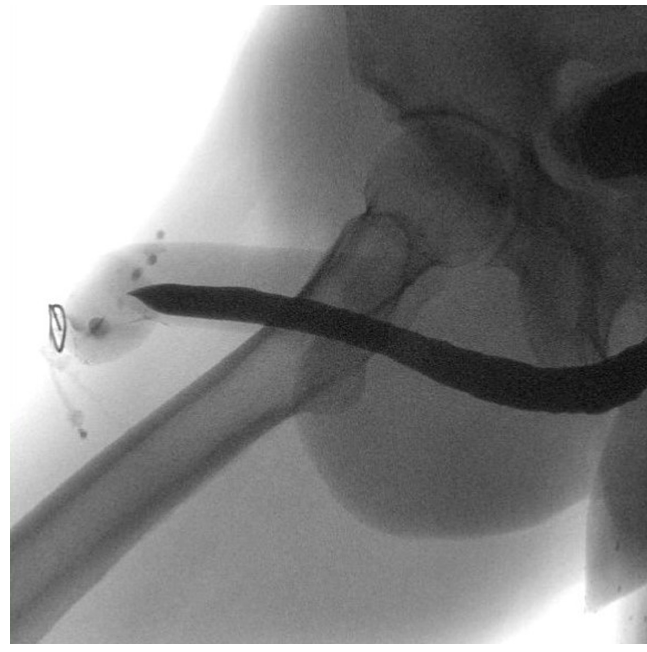
Figure 1. Antegrade urethrogram of the patient shows an obliterative stricture of approximately 3.5 cm starting from the subcoronal and running up to the fossa navicularis. Dilatation of the remaining anterior urethra is seen, running up to a triangular complete obliteration. The posterior urethra, although not in the picture, was free of any